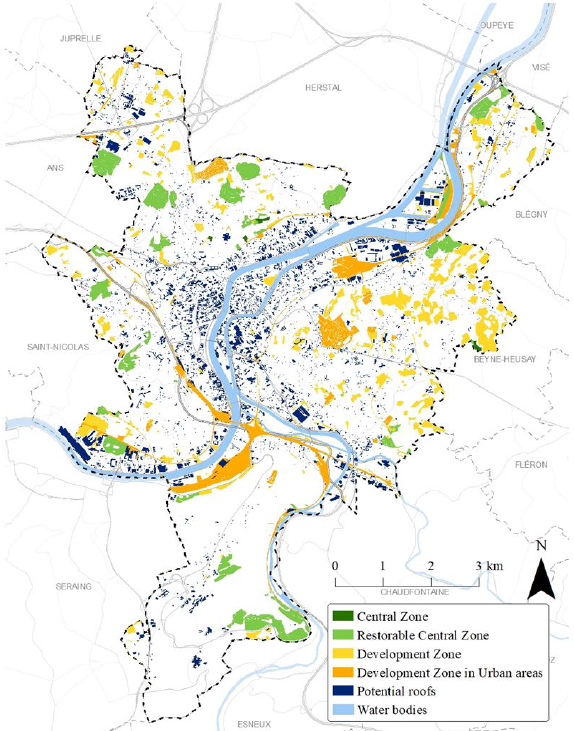
Figure 3 . Ecological network zones with dry lawns and meadows environment (Source - ecological network: PCDN de la Ville de Liège, IGN-Top10v et Smartpop) The central zone has total 6 sites with dry lawns and